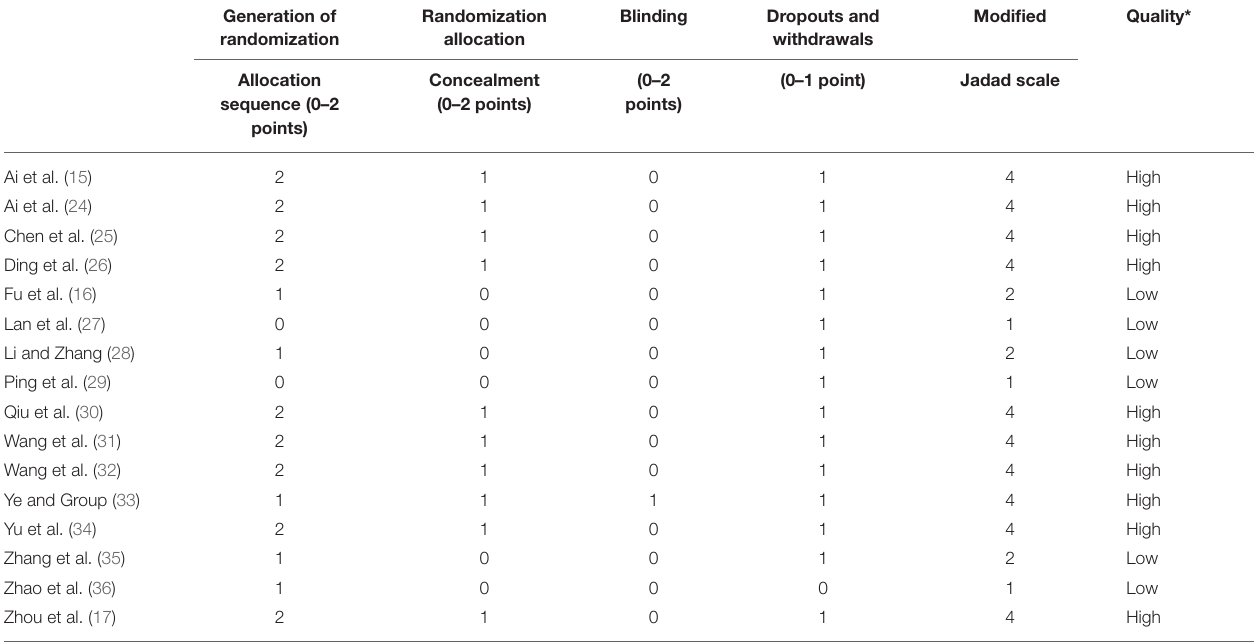
TABLE 3 | Modified Jadad scale for the included